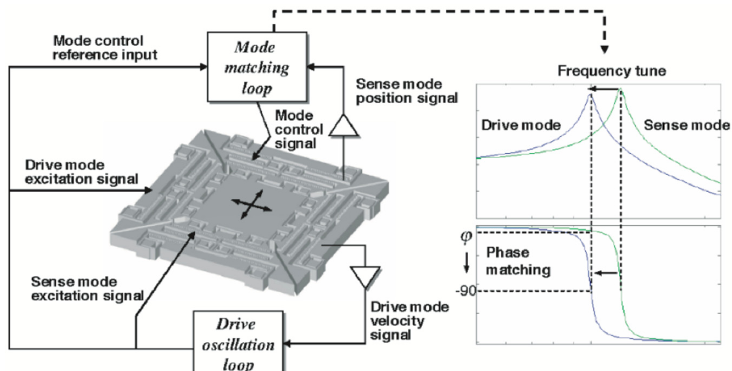
Figure 13. The mode-matching method based on phase domain analysis from the Konkuk University.